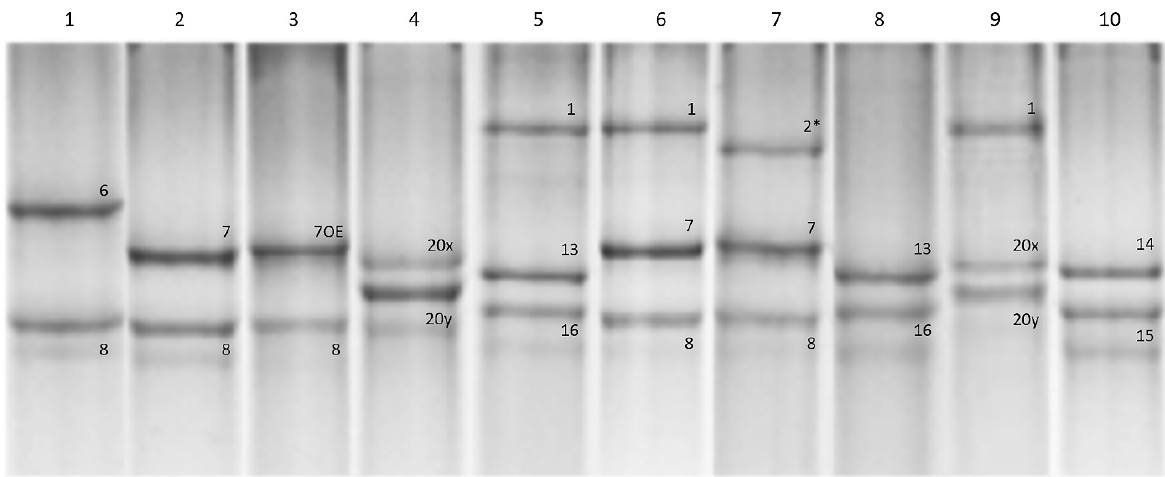
Figure 1. Patterns of HMW-GS subunit compositions in the studied collection of winter durum wheat as revealed using SDS-PAGE analysis. Accessions are as follows: 1, 3680h62; 2, 3591h96; 3, MV Hundur; 4, MVTD 15-98; 5, Yakhont (760/10); 6, Yubilarka (330/10); 7, 3561h28; 8, 3796h33; 9, Donchanka; 10, MV Pennedur; 2* denotes subunit Ax2*. The allelic combination Glu-A1c + Glu-B1b had the highest proportion (32 accessions), combinations Glu-A1c + Glu-B1al and Glu-A1c + Glu-B1e were approximately equally represented (12 and 10 accessions, respectively) and Glu-A1a + Glu-B1b and Glu-A1c + Glu- B1f also had approximately equal lower frequencies (7 and 6 accessions, respectively); each of Glu-A1a + Glu-B1f , Glu-A1b + Glu-B1b and Glu-A1c + Glu-B1d were found in two cultivars. Each of the Glu-A1a + Glu-B1al , Glu-A1a + Glu-B1e and Glu-A1c + Glu-B1h genotypes were identified in only one cultivar and therefore excluded from the